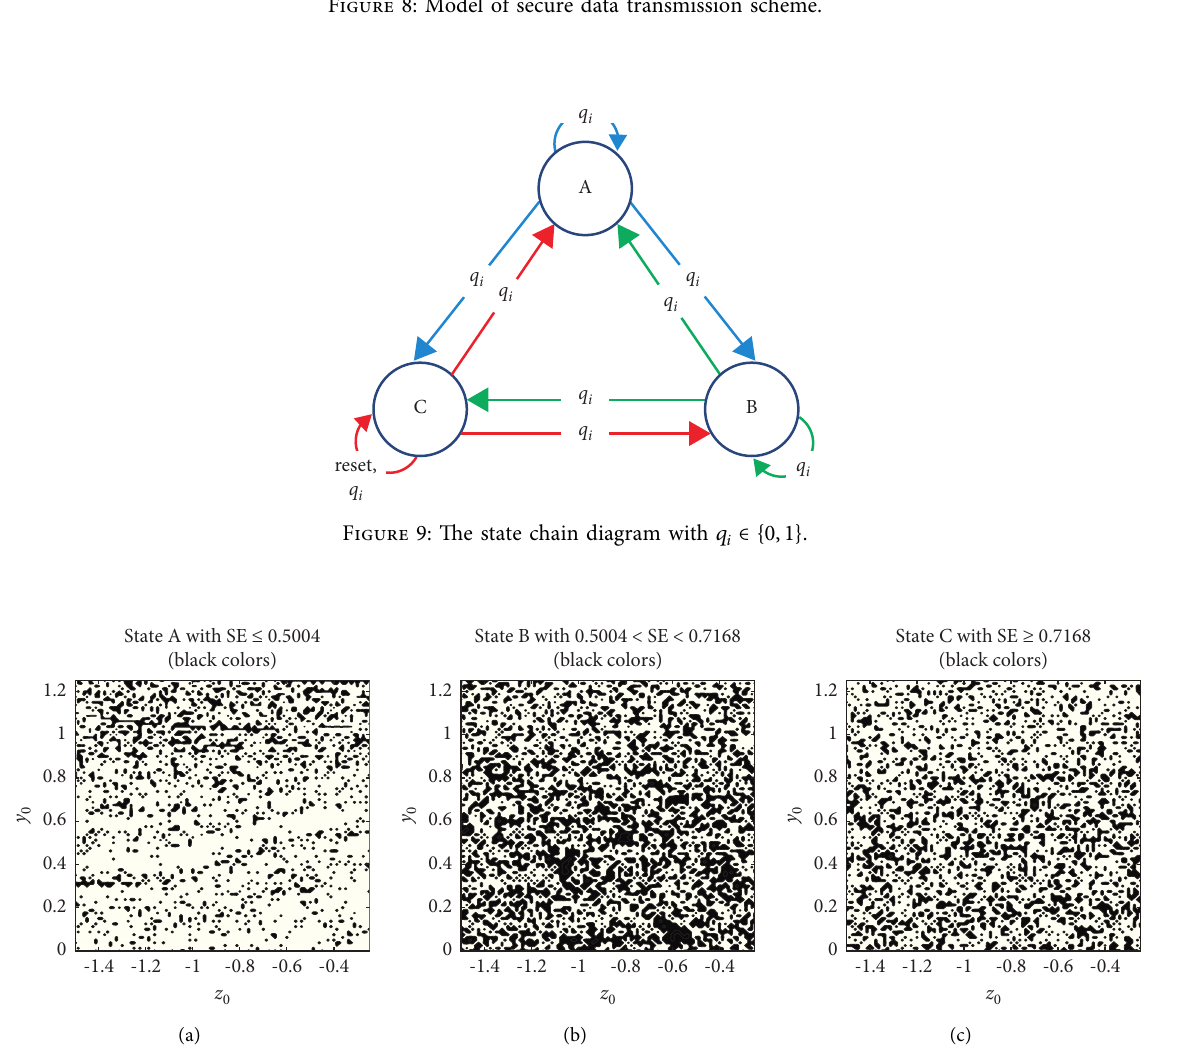
− z plane, (a) SE ≤ 0 . 55, (b) 0 . 55 < SE < 0 . 7, and (c) SE ≥ 0 . 7. 0 0